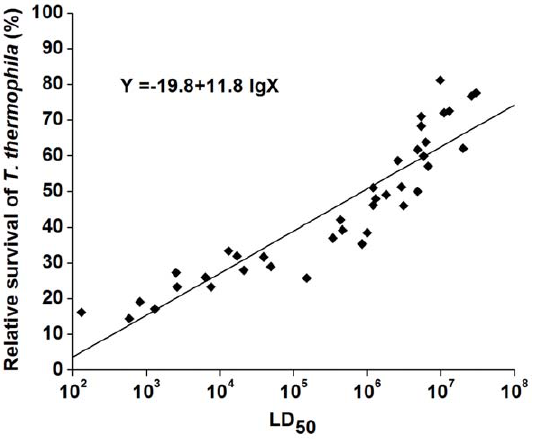
Figure 7. Linear regression model to predict relative survival of Aeromonas isolates from LD 50 values. Concentrations of Aeromonas and T. thermophila cells at the start of the experiment were 5 6 10 8 CFU/ ml and 1 6 10 5 cells/ml, respectively. LD 50 s of 39 Aeromonas isolates in zebrafish were used as the abscissa and a trend line was added. Each experiment was repeated a minimum of four times. Data presented represent the mean of a four replicates.